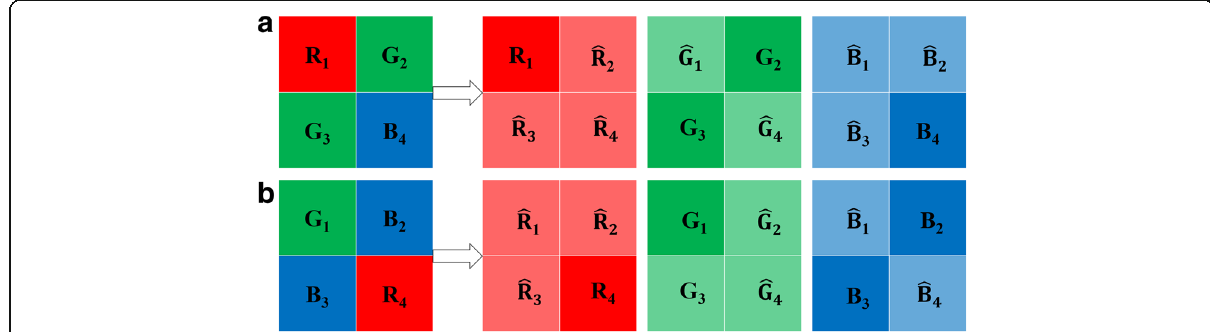
Fig. 1 An example of color sample changes in the demosaicing process. a Original color samples. b Modified color samples through color